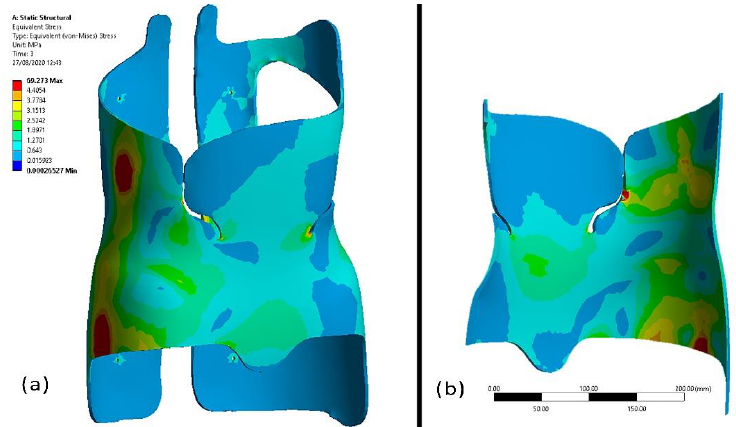
Figure 7. View of orthosis with values of von Mises stress: ( a ) left side—front from exterior, ( b ) right side—front from interior.